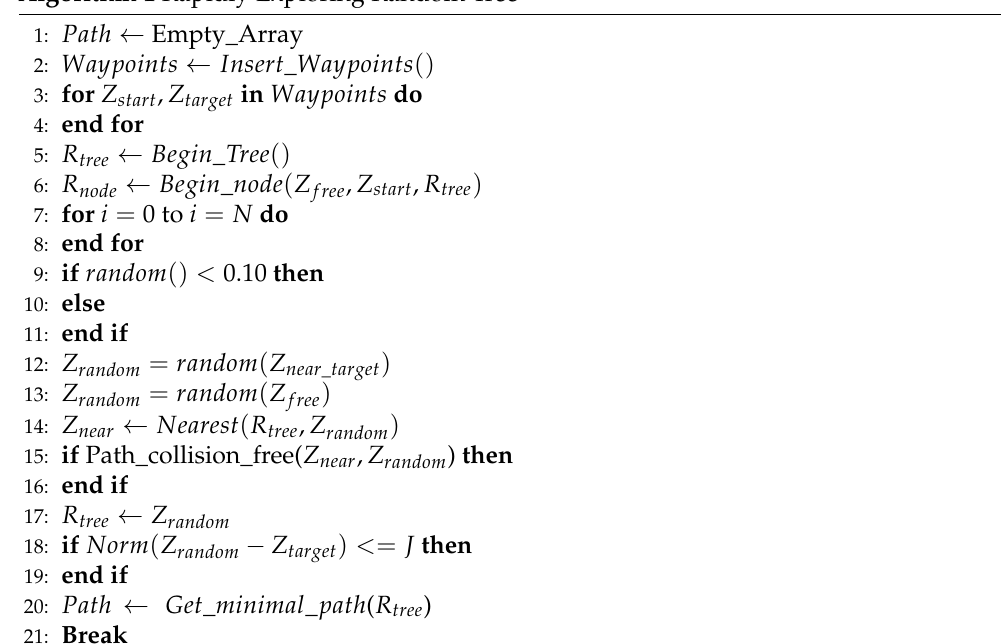
Algorithm 1 Rapidly Exploring Random